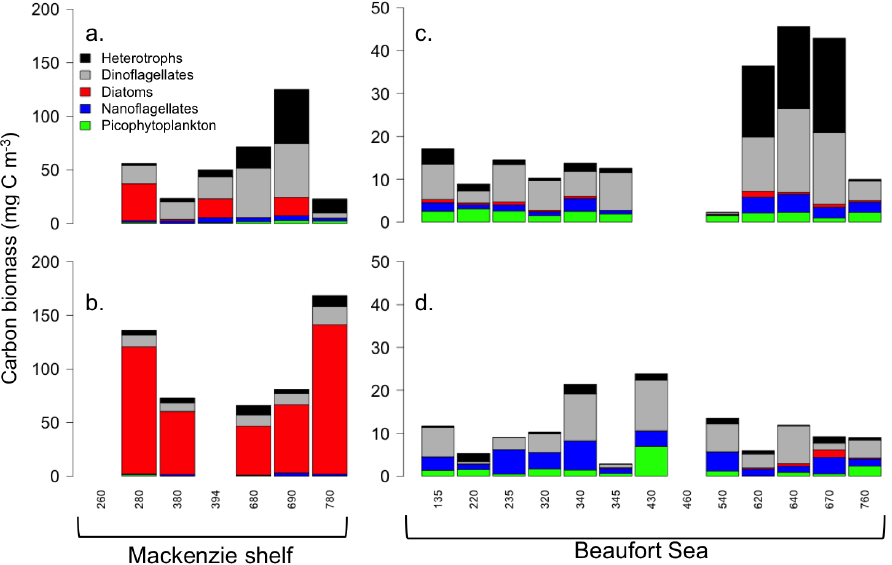
Figure 7. Carbon biomass of five protist groups in (a, c) surface and at the (b, d) subsurface chlorophyll maximum (SCM) depth of the (a, b) Mackenzie shelf and (c, d) deep waters of the Beaufort